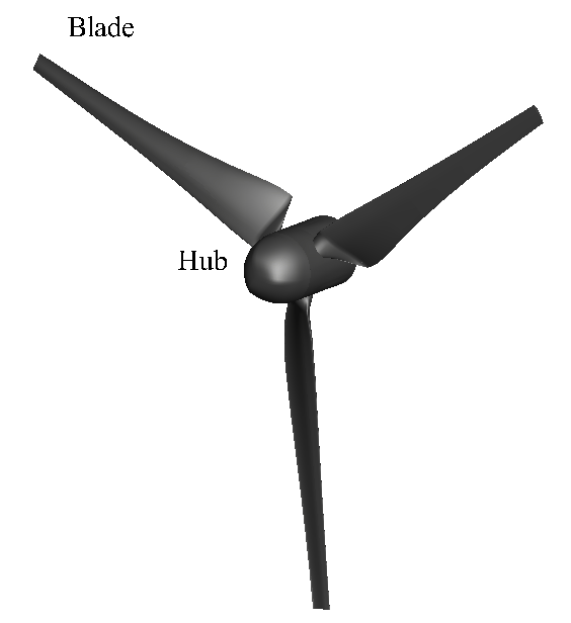
Figure 4. Geometry of the turbine